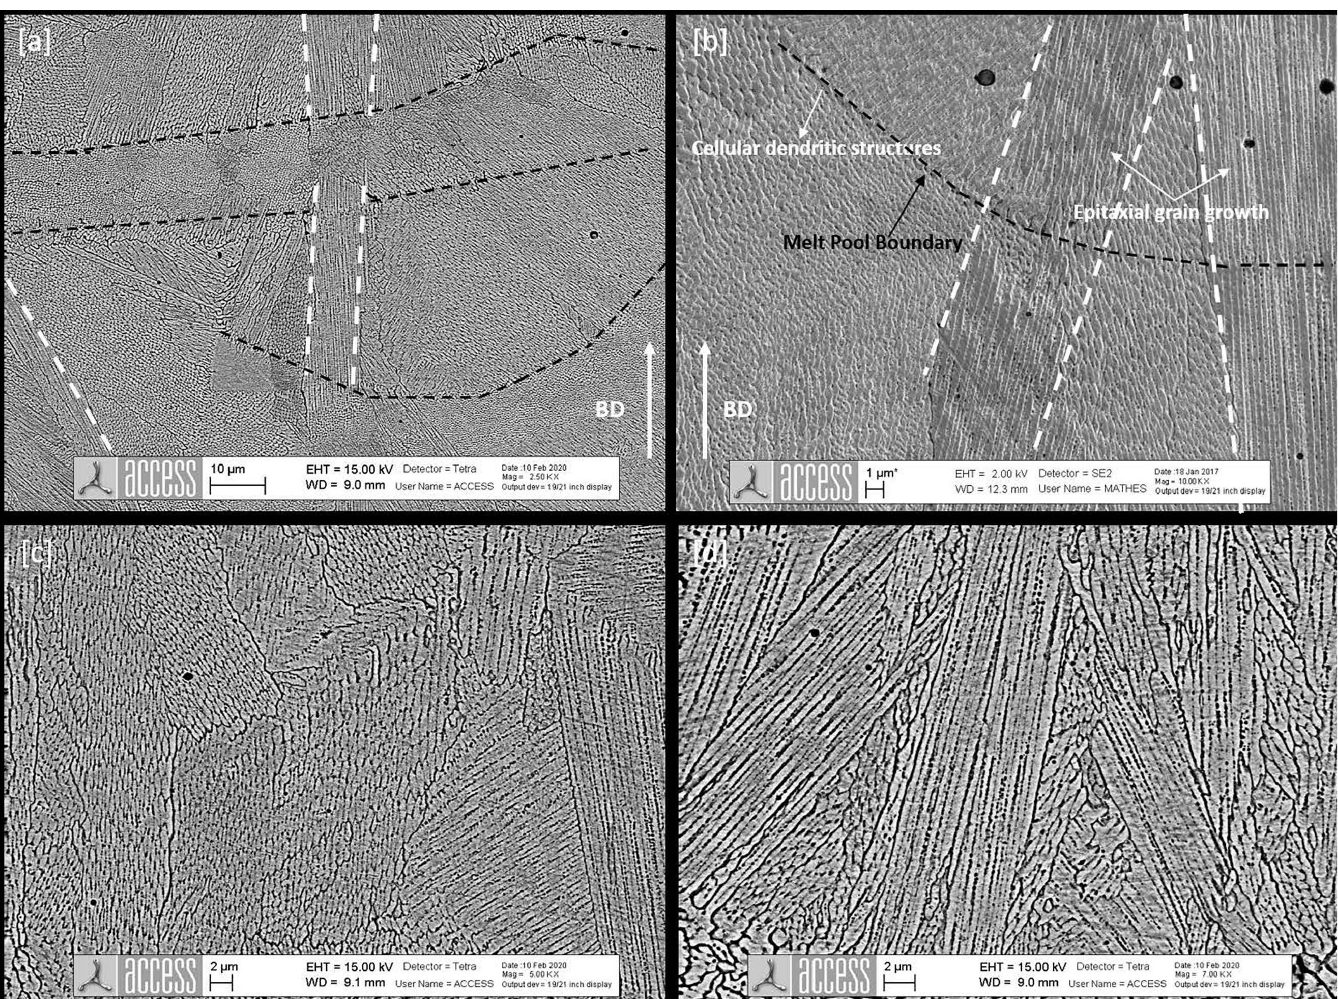
Figure 5. SEM micrographs of as-built laser powder bed fusion (LPBF) samples at 140 µ m (Ys): at 550 mm / s ( a ) showing discontinuity in epitaxial growth; ( b ) combination of both epitaxial and cellular dendritic structures; at 850 mm / s ( c ), ( d ) di ff erent subgrain orientations at higher